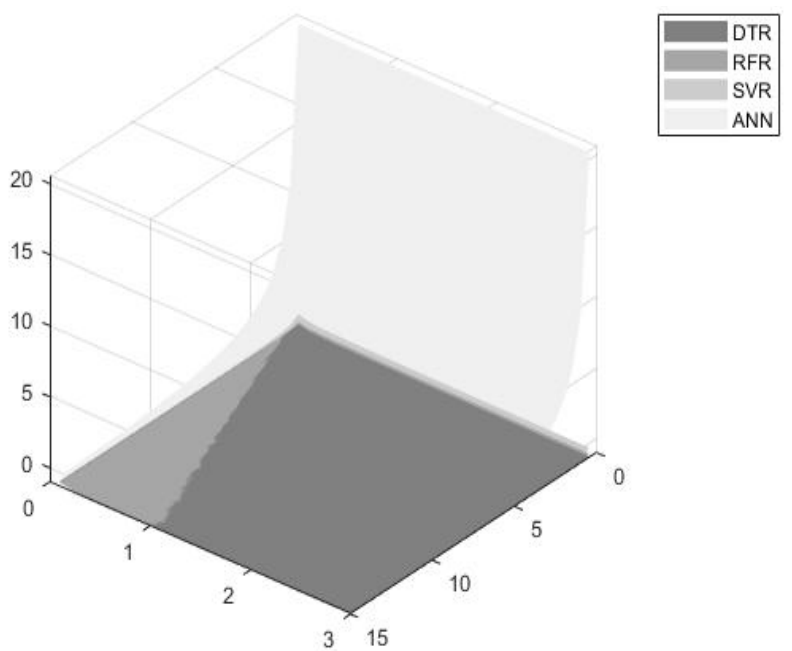
Figure 1. Sensitivity Analysis of Accuracy and Time significance weights.